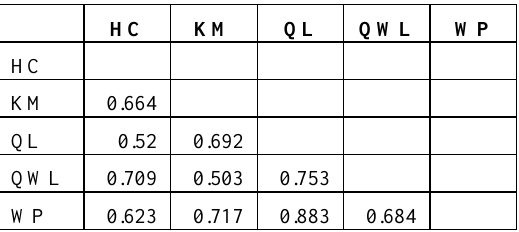
Table 10: Heterotrait-Monotrait Ratio for Higher- Order Constructs